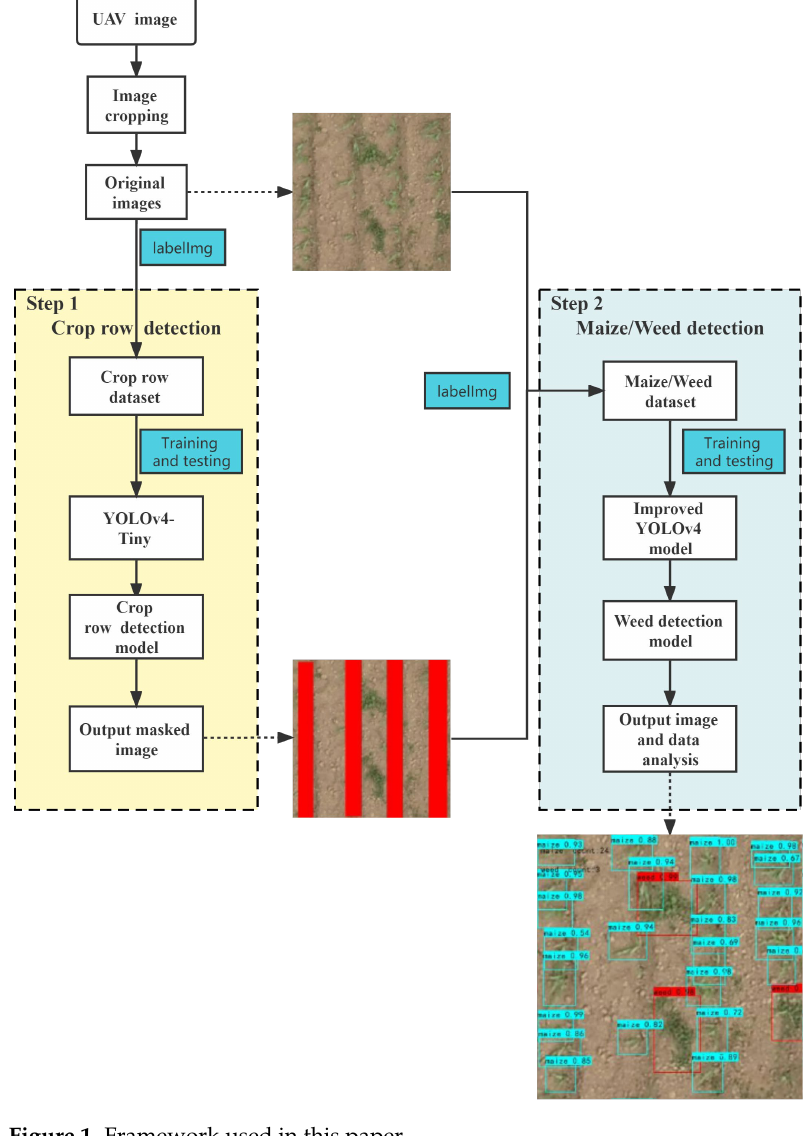
Figure 1. Framework used in this